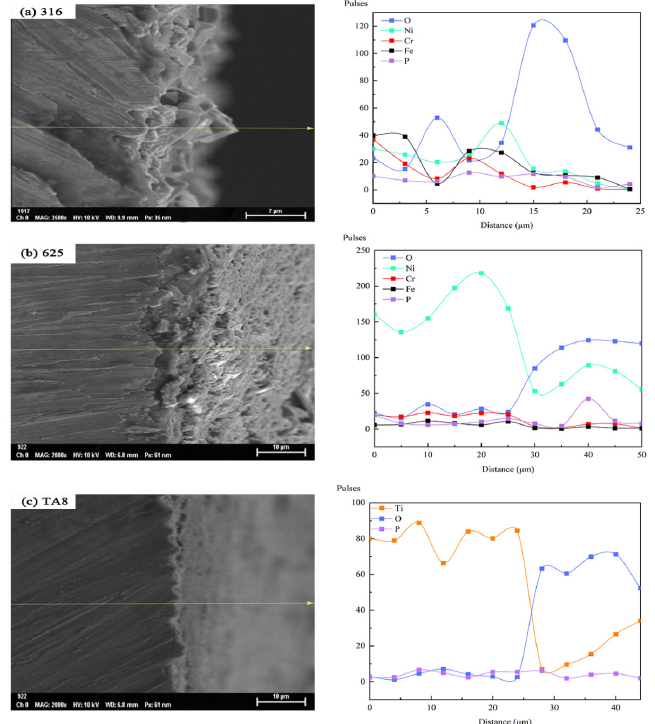
Figure 8. SEM morphologies and EDS line scan of the cross-section of the oxide films formed on the specimens after exposure in SCW at experiment Run-6 for 200 h, respectively; (a) 316 SS at the bot- tom reaction tube; (b) Alloy 625 at the bottom reaction tube; (c) TA8 at the bottom reaction